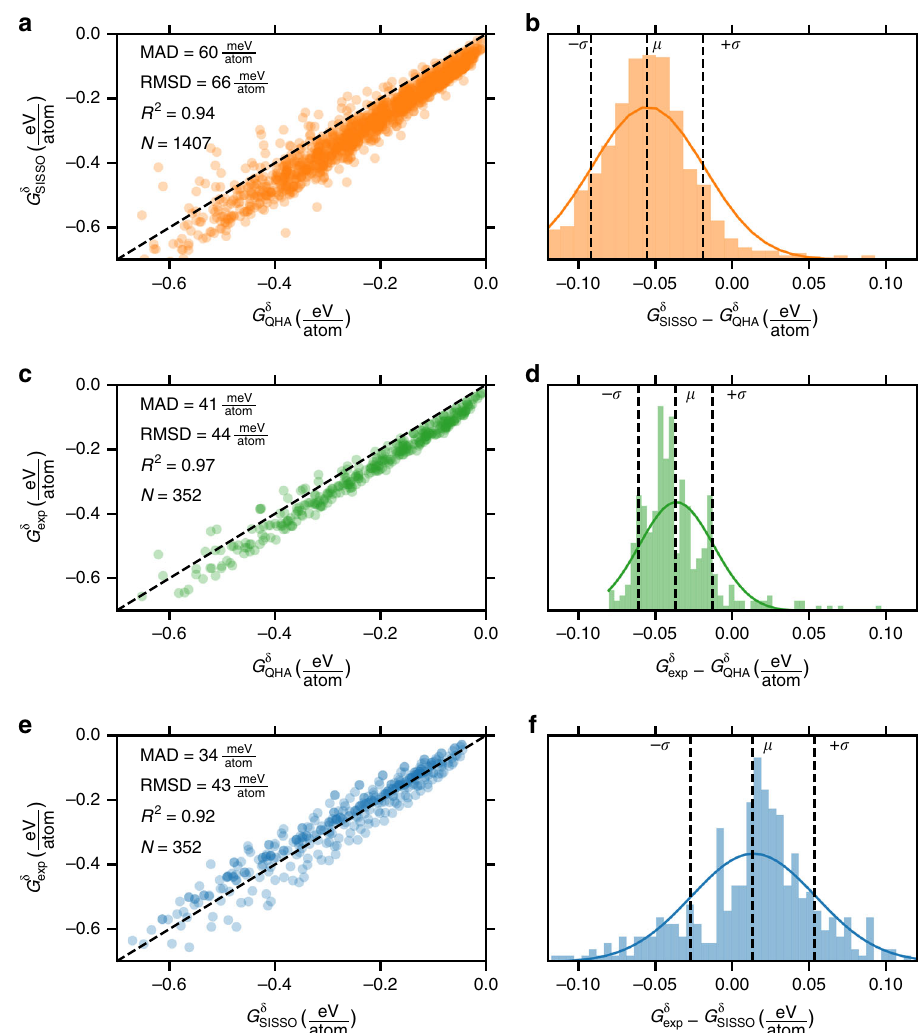
Fig. 3 Benchmarking descriptor against ab initio methods. a Comparing the SISSO-learned descriptor to QHA for 131 compounds not in the experimental dataset used to train or test the descriptor. b Distribution of residuals shown in a . c Comparing QHA to experiment for 37 compounds which appear in both FactSage and PhononDB. d Distribution of residuals shown in c . e Comparing the SISSO-learned descriptor to experiment of these same 37 compounds shown in c . f Distribution of residuals shown in e . The annotation within each fi gure is provided in the Fig. 2